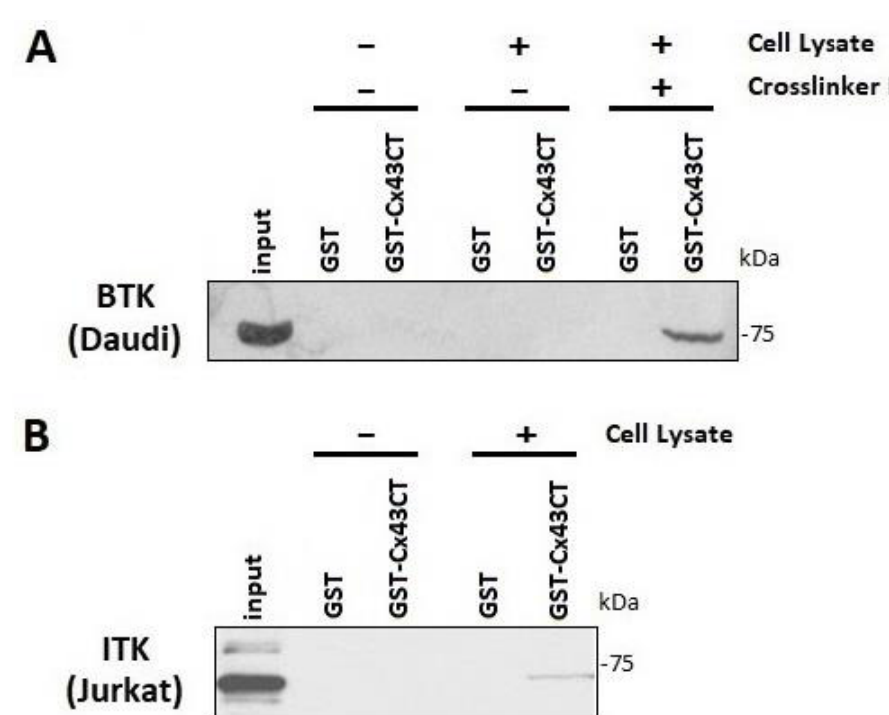
Figure 2. Confirming the direct Cx43 interaction with BTK and ITK. ( A ) GST pull-down assay was performed in Daudi cells with GST (control), GST-Cx43CT immobilized on glutathione beads, and GST-Cx43CT in the presence of crosslinker DTSSP. Pulled-down proteins were analyzed by Western blot using an anti-BTK antibody. ( B ) The GST pull-down assay was conducted in Jurkat cells with GST only and GST-Cx43CT immobilized on glutathione beads. Pulled-down proteins were analyzed by Western blot using an anti-ITK antibody.